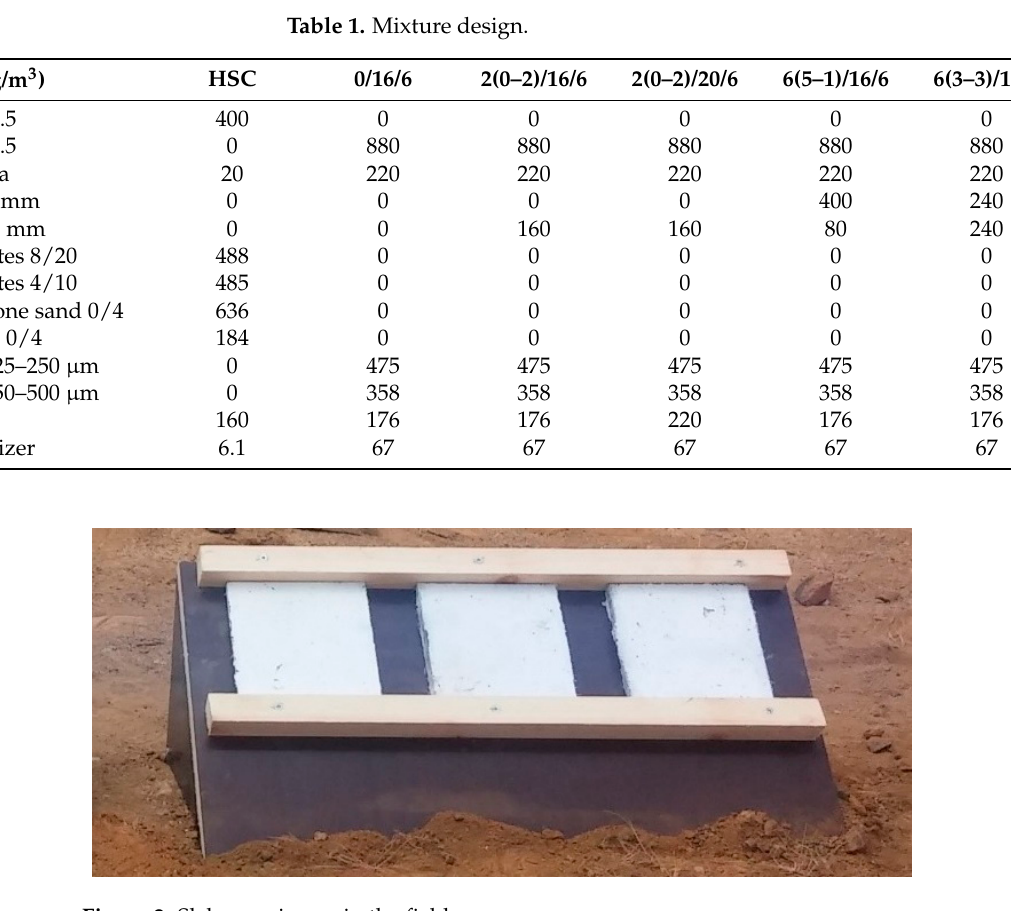
Figure 2. Slabs specimens in the field.